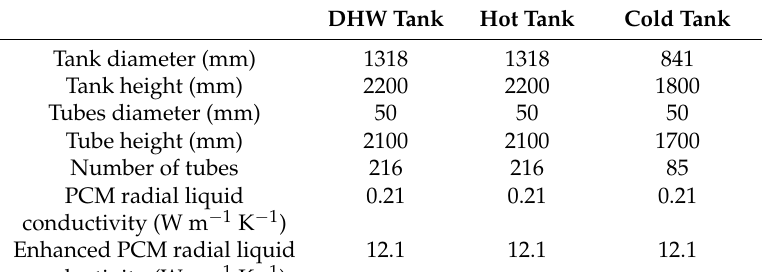
Table 6. Main parameters of type 860 simulating the three hybrid water–PCM thermal storage tanks as described in Figure 8.